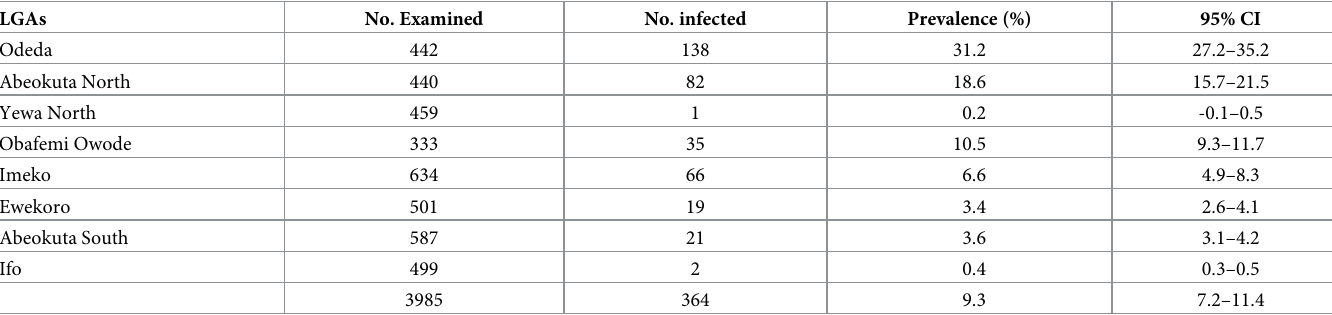
Table 2. Summary of Onchocerciasis prevalence across the selected LGAs.